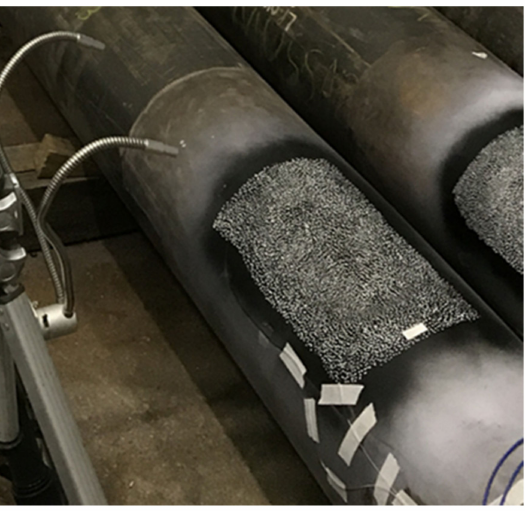
Figure 1. Speckle pattern on specimen surface as required for DIC